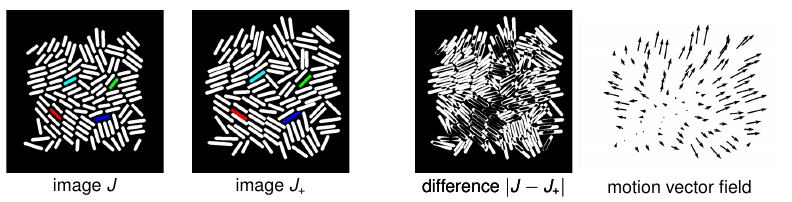
Figure 4. Simulated cell dynamics. From left to right, two successive simulated images J and J + with an interframe time of six minutes and no cell division, their image difference associated motion vectors. For the image J and J + we color four pairs of cells in B should be matched by the true cell registration mapping. Notice that the motion for an interframe time of six minutes is significant. We can observe that, even without considering cell division, we can no longer assume that corresponding cells in frame J and J +